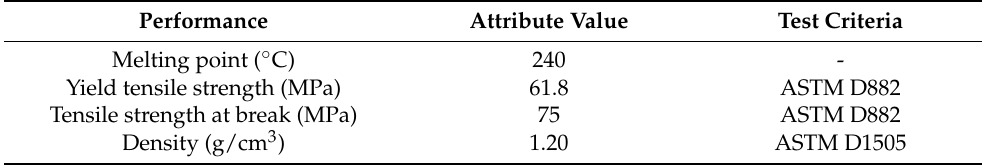
Table 2. Performance parameters of PC-110 granular material.